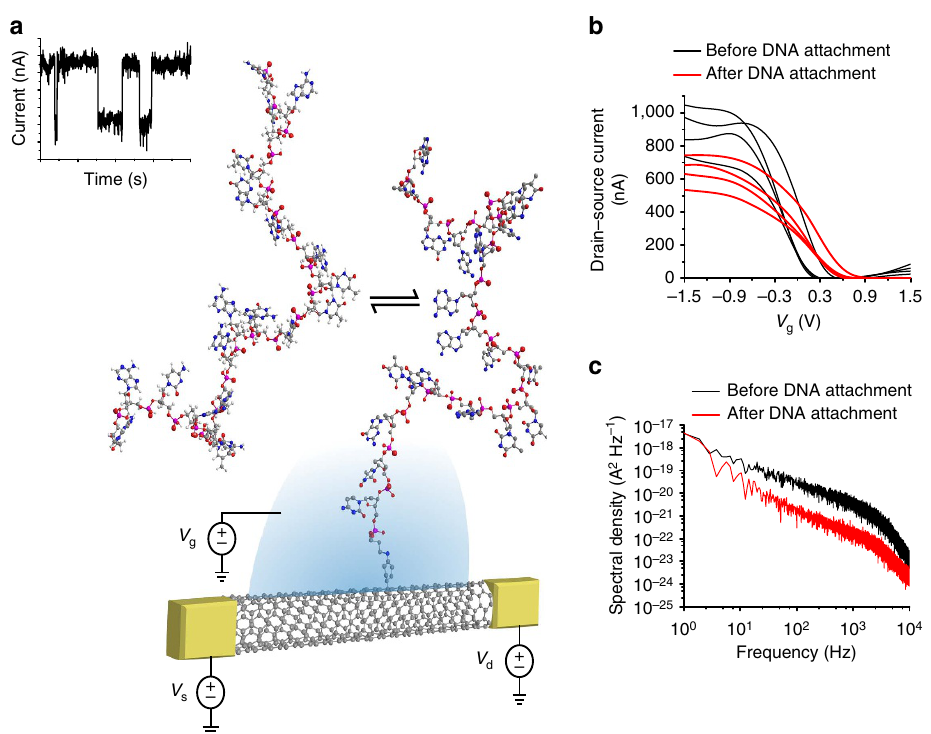
Figure 1 | smFET device characteristics. ( a ) To-scale illustration of the smFET device structure. An amine-modified oligonucleotide probe is covalently coupled to a single defect site, generated on a single-walled carbon nanotube (SWCNT) sidewall via diazonium chemistry. The CNTacts as the channel of a field-effect transistor, transducing biomolecular charge into a conductance change in the smFET. Binding and melting reactions of a complementary oligonucleotide generate random telegraph signals (RTSs, shown in inset), which correspond to hybridization and melting events. Experiments are performed at a constant source–drain bias ( V s ) of 100mV, while the electrolytic gate bias is modulated by an on-chip pseudo-reference electrode. ( b ) Representative transfer ( I – V ) characteristics of four CNT devices before and after point functionalization and DNA attachment. V g is the bias on the platinum pseudo-reference electrode relative to the device. V g is varied from (cid:2) 1.5V to þ 1.5V (in acetonitrile solution supported by 0.1M tetrabutylamonium hexafluorophosphate). ( c ) The power spectral densities (PSDs) of the devices from b showing a strong flicker (1/ f ) noise component before (black line) and after (red line) modification. While the newly formed defect dominates transfer characteristics, the CNT sidewall becomes less sensitive to charge traps, leading to lower flicker